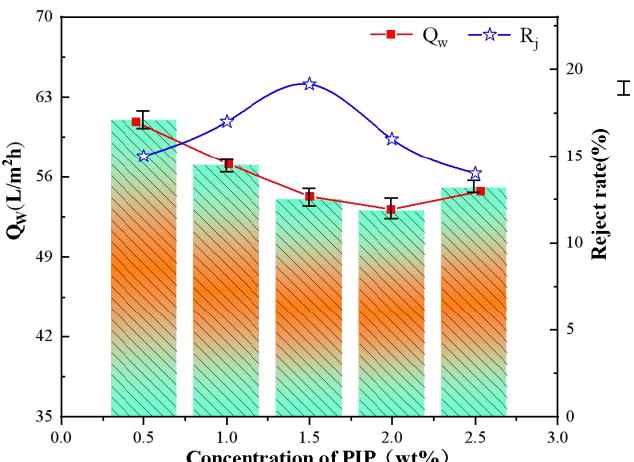
Figure 3. Influence of PIP concentration on the water flux (Q W ) and salt filtration performance (R j ) of NFMs.